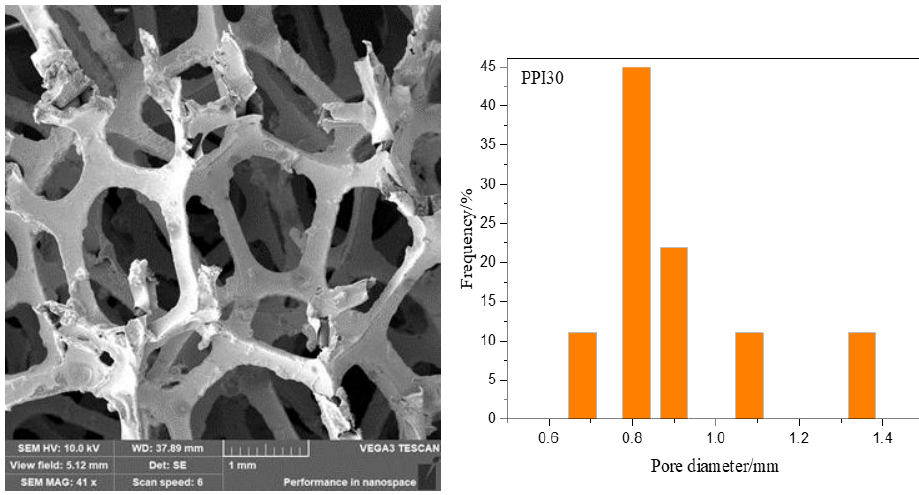
Figure 1. SEM image and pore diameter distribution of PPI30 .